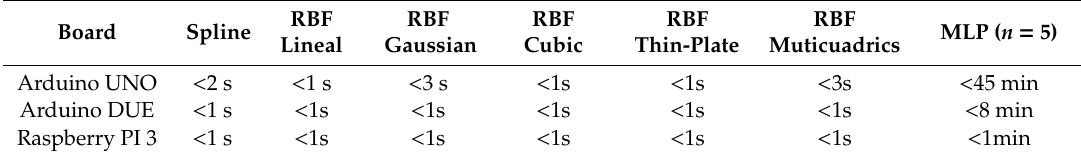
Table 6. Processing time in Arduino UNO, DUE and Rapsberry Pi3.